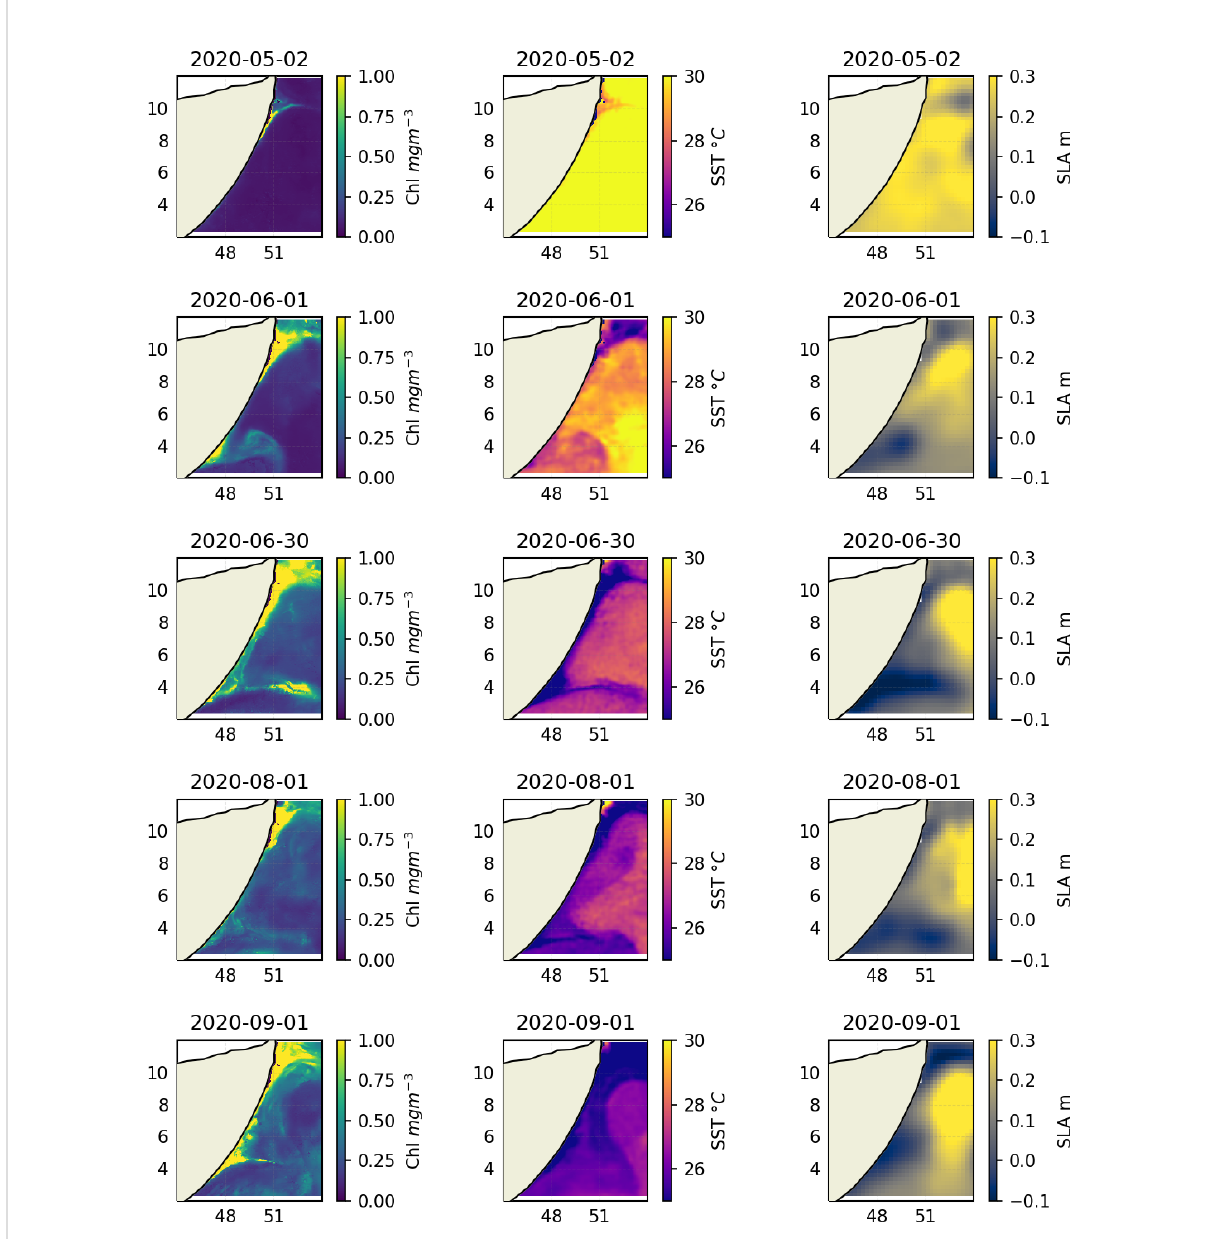
FIGURE 1 Example maps of the three different variables expected to be linked to upwelling over the SE monsoon season. Each row indicates a different day, over 2020, separated by 1 month. The variables are: (leftmost column) Chl, (centre column) SST, and (rightmost column)